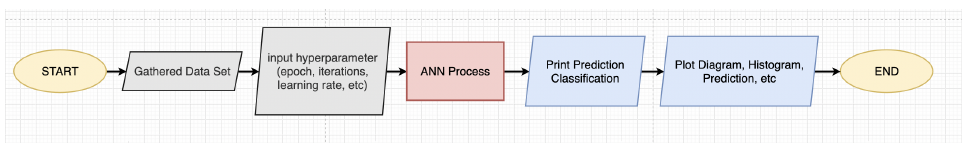
Figure 8. Detailed breakdown of the steps in